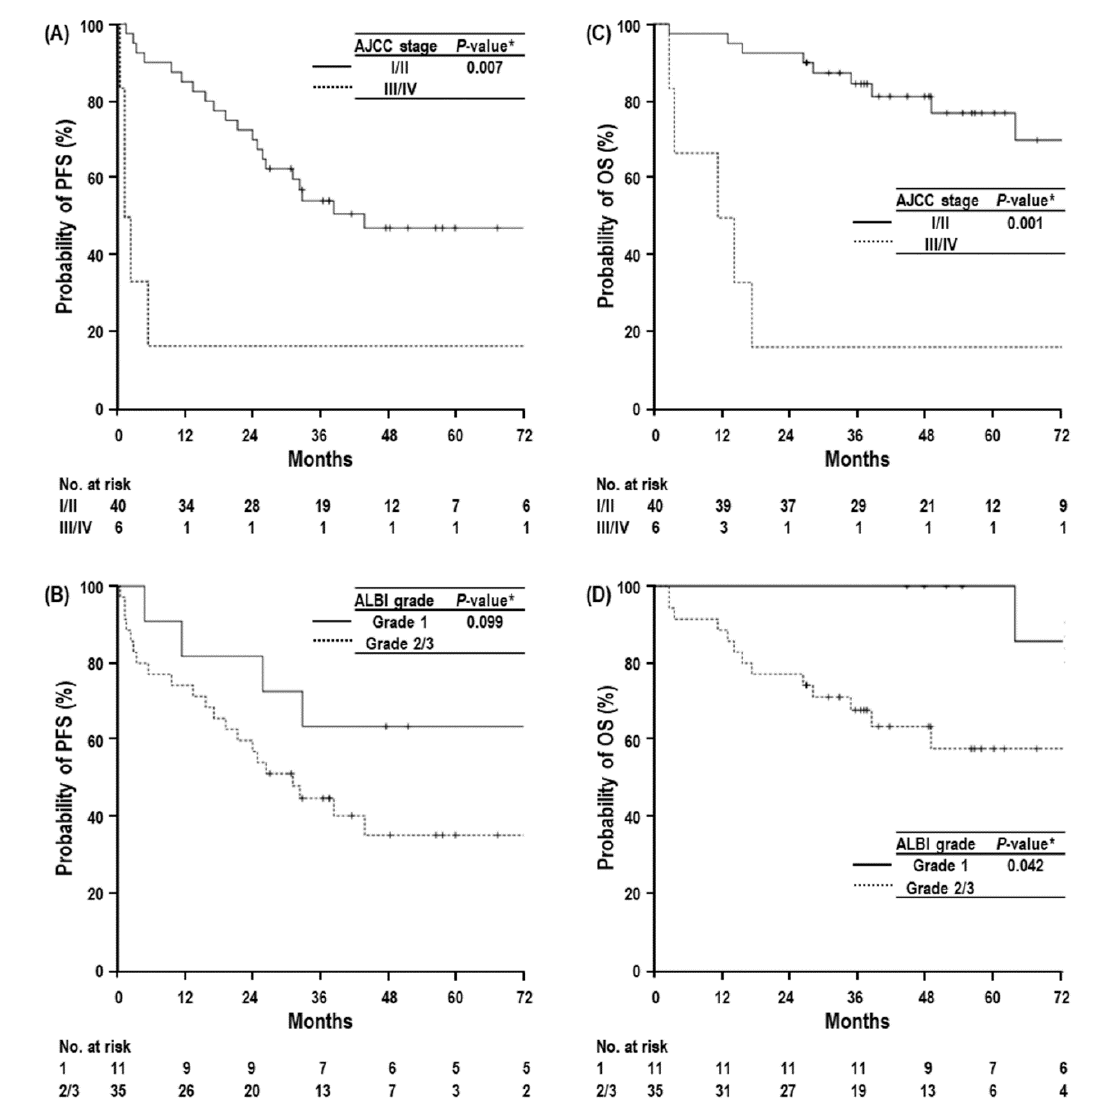
Figure 2. Progression-free survival (PFS) curves according to AJCC stage ( A ) and ALBI grade ( B ) in all patients, and overall survival (OS) curves according to AJCC stage ( C ) and ALBI grade ( D ). Abbreviations: AJCC stage, American Joint Committee on Cancer stage; ALBI grade, albumin- bilirubin grade. * log-rank test.